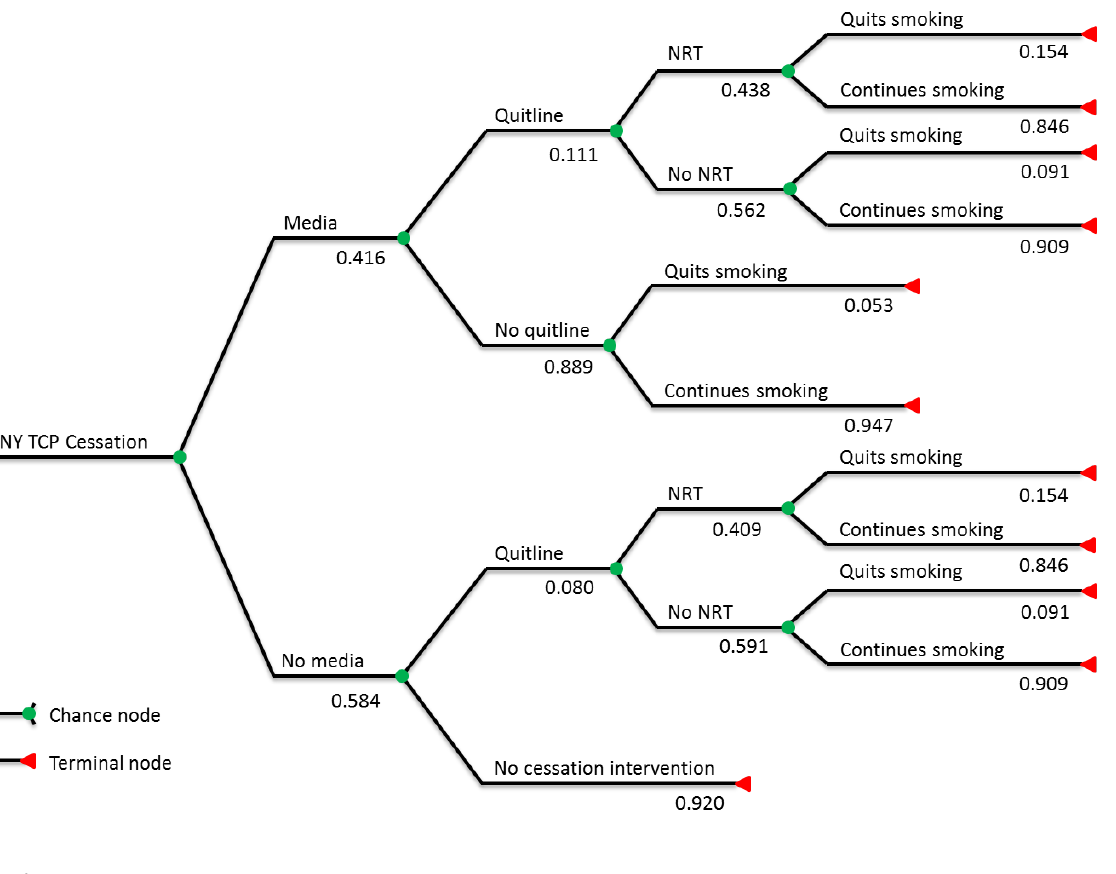
Figure 1. Simulation tree with branch expected